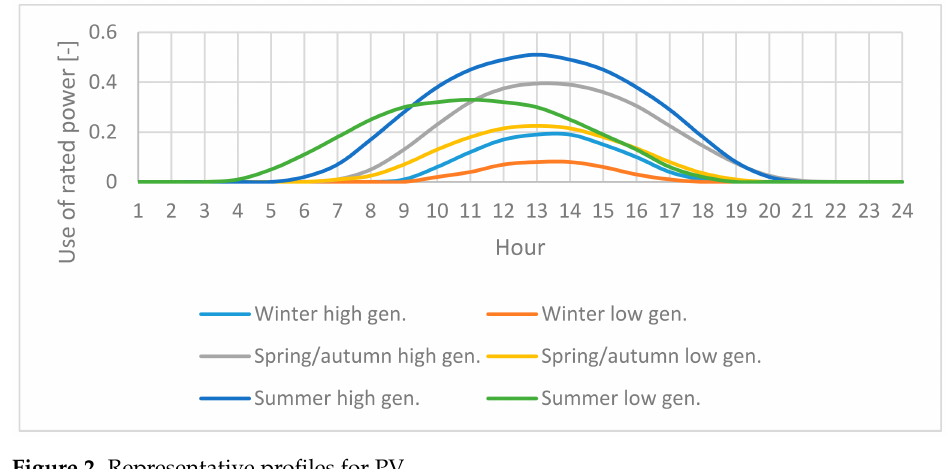
Figure 2. Representative profiles for PV.